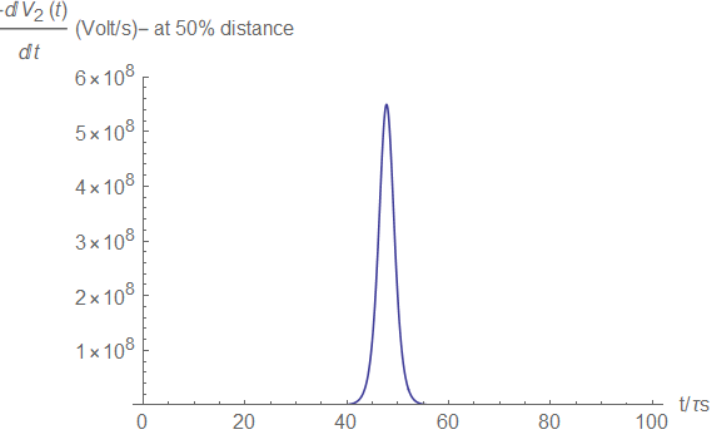
Figure A15. Voltage derivative at half the distance between the short and the